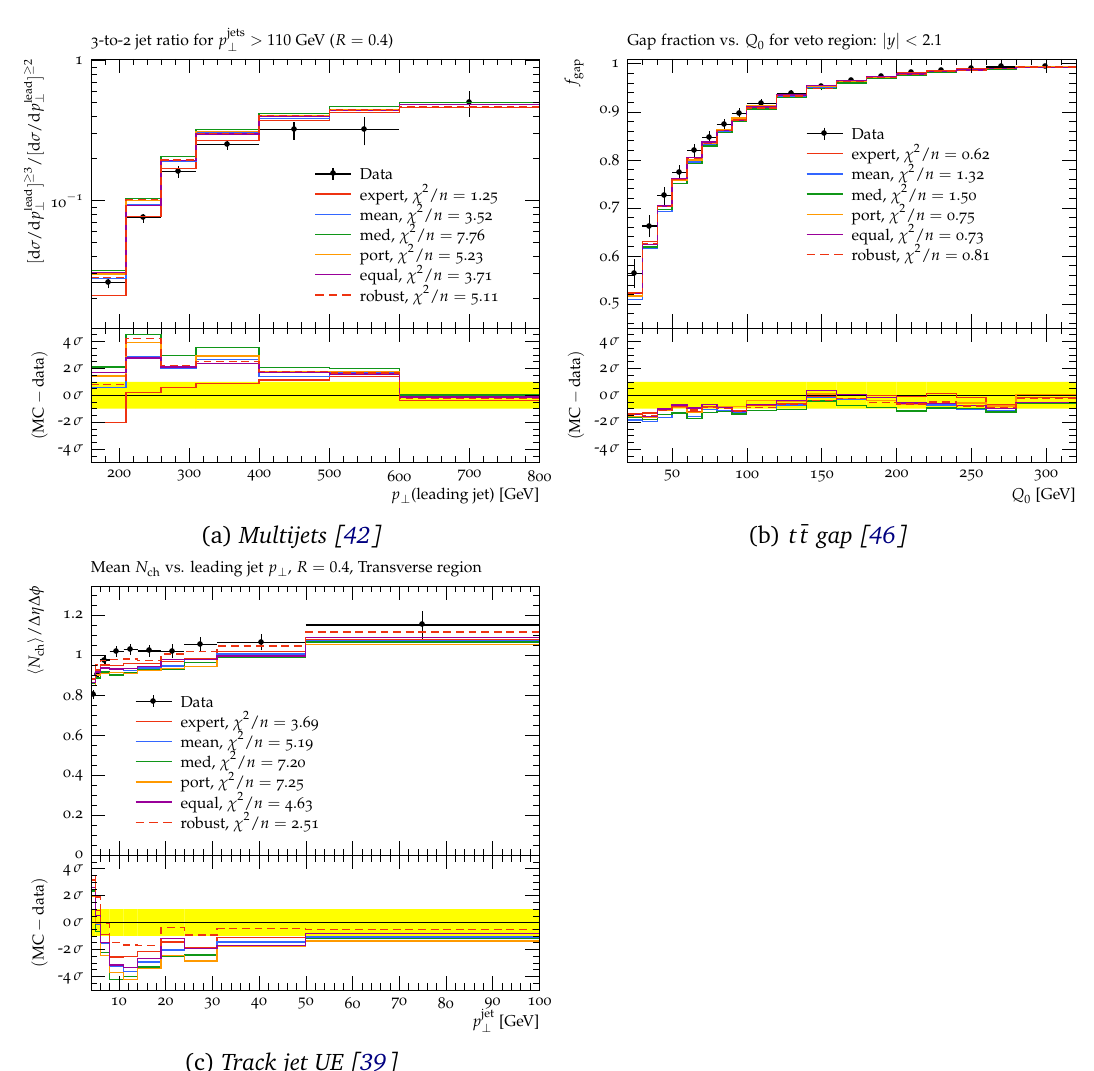
values for which the automated O